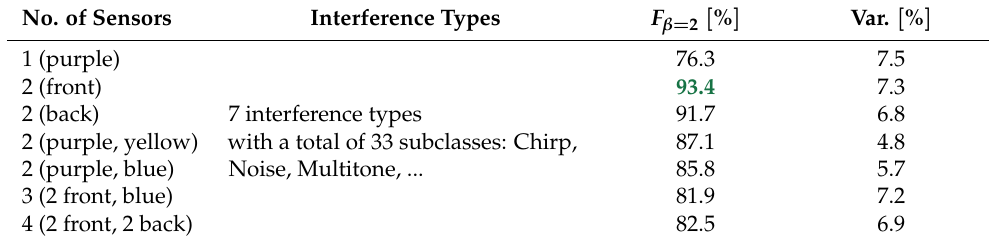
Table 3. Results of our lane detection experiment. The best value is shown in green and bold. No. of